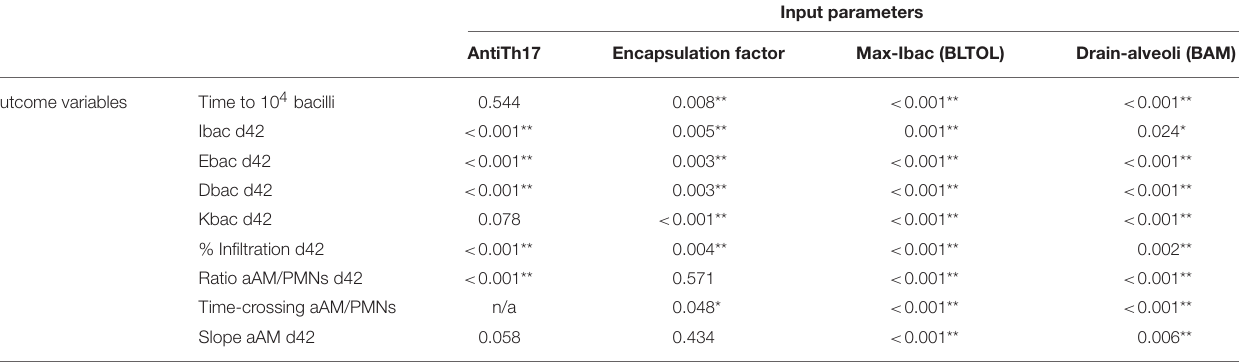
TABLE 1 | One-way